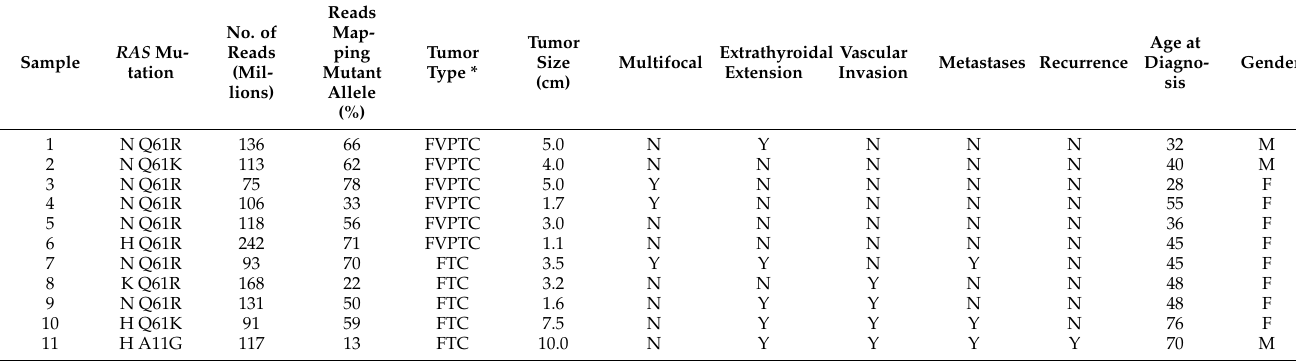
Table 1. Clinical pathological features of the RAS -positive cohort and sequencing coverage.